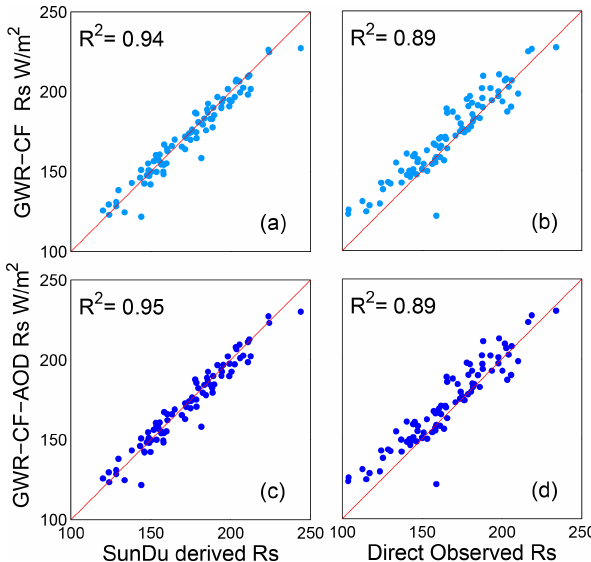
Figure 6. Comparison of multiyear mean surface solar radiation ( R s ) derived from the GWR method. Panels (a) and (c) represent validation results using SunDu-derived R s data as a reference, while that of panels (b) and (d) uses directly observed R s